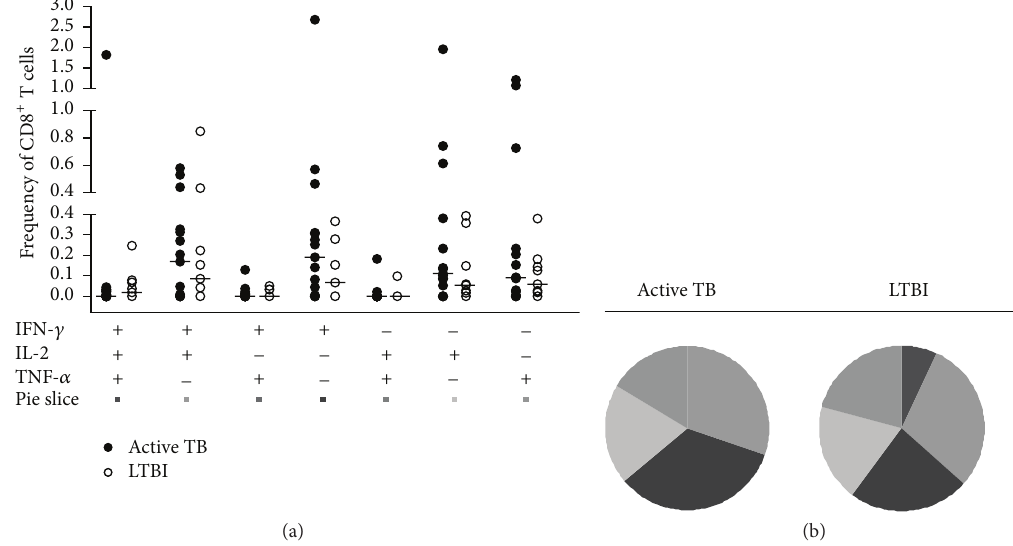
Figure 6: Multifunctional cytokine analysis of Mtb -specific CD8 + T cells. (a) Frequency of Mtb -specific CD8 + T cells producing all combinations of IFN- 𝛾 , IL-2, and TNF- 𝛼 in active TB patients ( 𝑛 = 18 , black circles) and in LTBI patients ( 𝑛 = 10 , white circles). Horizontal barsrepresentthemedianvalues.StatisticalanalysiswasperformedusingMann-Whitneytest.(b)Piechartsrepresenttherelativeproportions ofcytokine-producingT-cellsubsetsineachgroupafter Mtb -specificstimulation.Akeytocoloursusedinthepiechartsisshownatthebottom of the panel